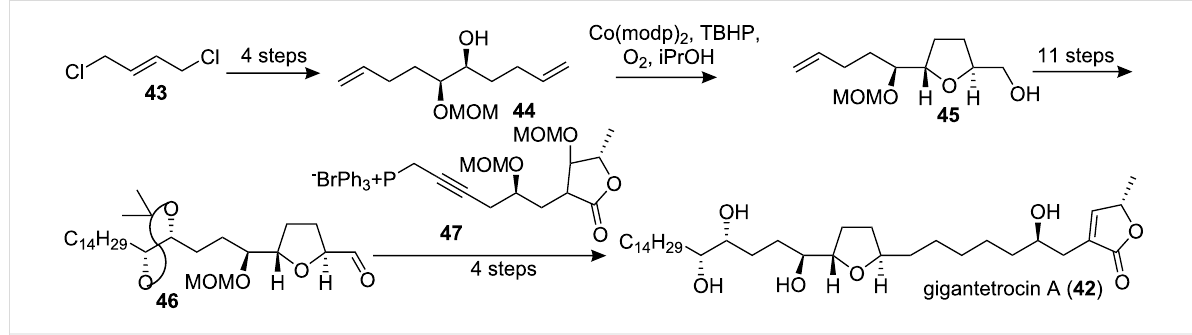
Scheme 6: Total synthesis of gigantetrocin A by Shi’s group.